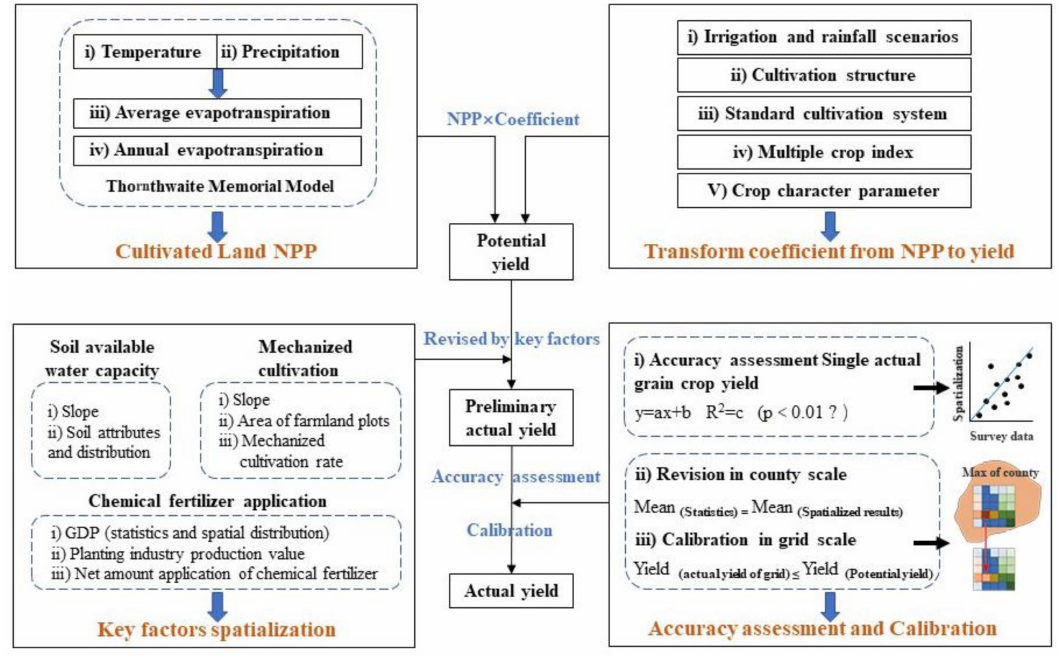
Figure 2. The framework of the grain crop yield spatialization (GCYS) model. NPP–Net Primary Productivity, R 2 –determination coe ffi cients, c-calculated results of determination coe ffi cients, p-probability level of obtaining the statistic, given that the null hypothesis is